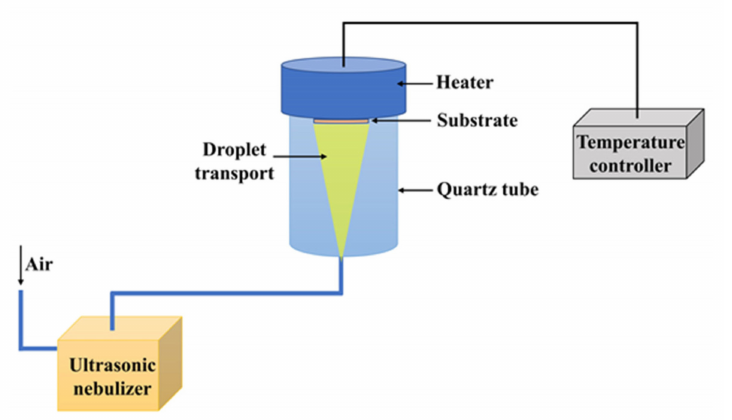
Figure 4. SP configuration for obtaining TiO 2 thin films. A static ultrasonic nebulizer generates a uniform distribution of the aerosols in the diameter range of 1 to 3 µ m. The aerosols generated are transported to the heated substrate (between 300 and 550 ◦ C), evaporate and react (on the substrate) to form the TiO 2